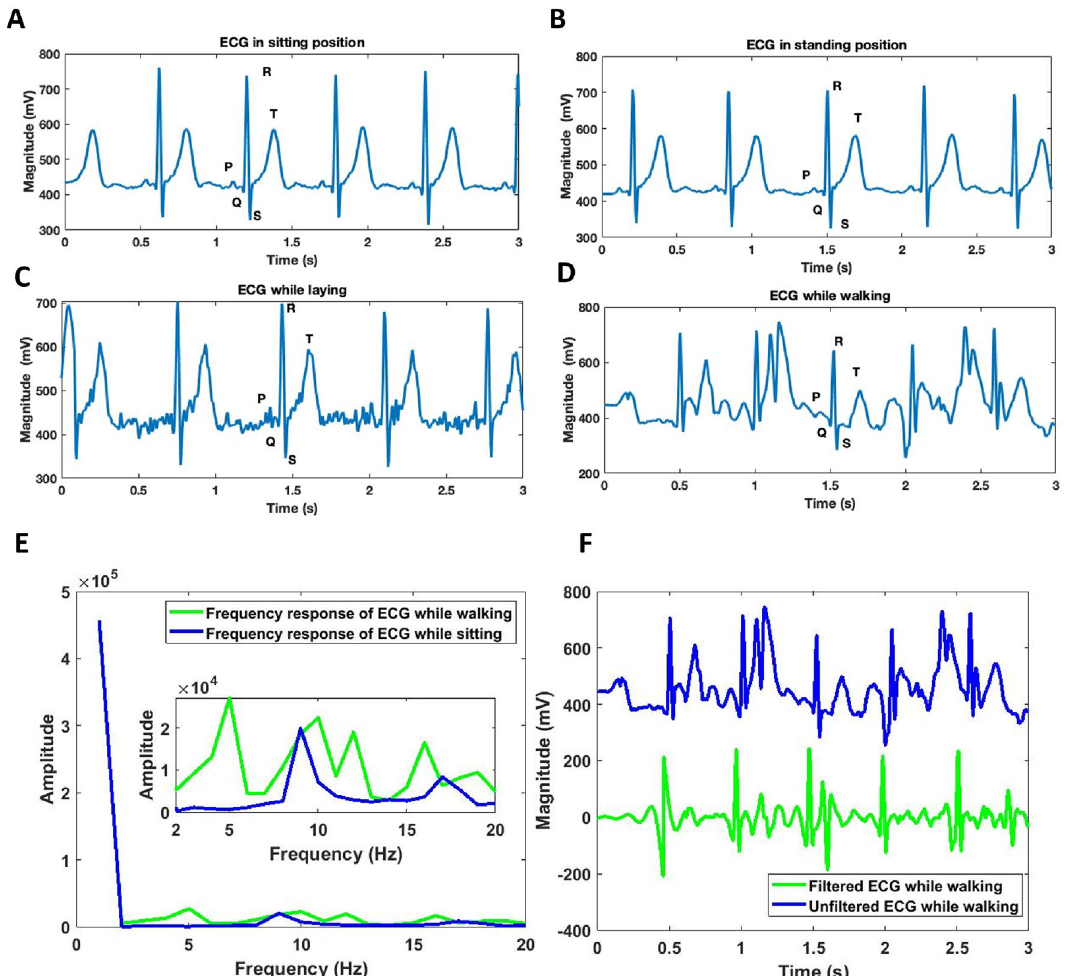
Figure 5. An ECG of a healthy subject with a clean and visible PQRST complex under different conditions ( A ). ECG while sitting ( B ). ECG while standing ( C ). ECG while laying ( D ). ECG while walking ( E ). Frequency response of ECG while sitting and while walking ( F ). ECG while walking before (blue) and after the high pass filter